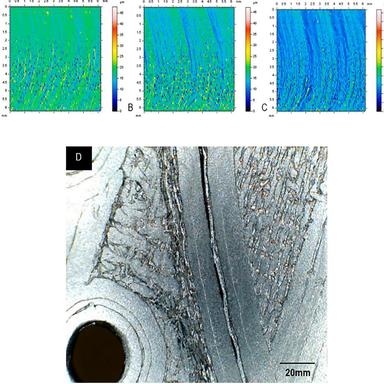
2D Topographical scans showing the surface of each deposited bead as the deposition speed is increased (A) 3 mm/s (B) 4 mm/s (C) 5 mm/s and (D) the formation of the surface produced showing the accuracy of the optimised final structure.